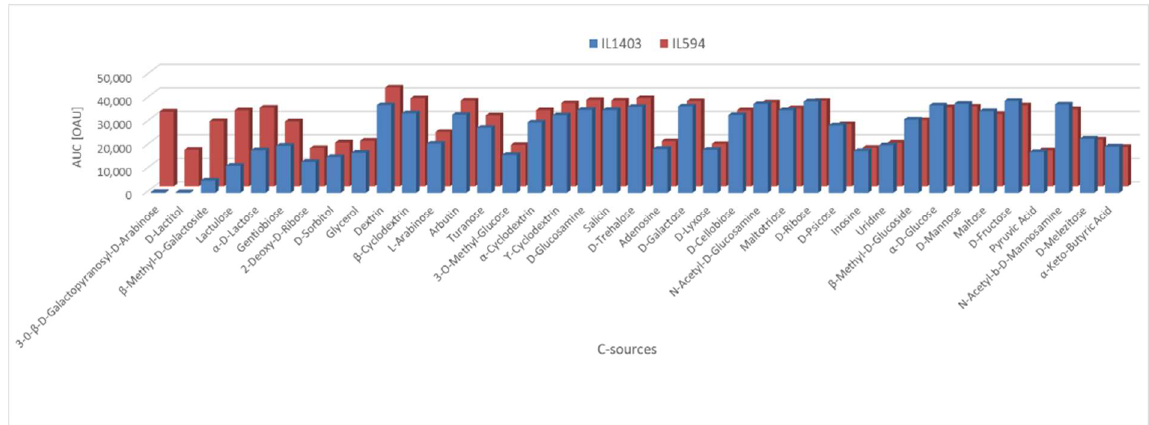
Figure 1. PM analysis for the utilization of carbon sources by L. lactis strains IL594 and IL1403. The height of the bars indicates the value of the area under the curve (AUC) of metabolic activity of the strains on a given C-source. Bars shown refer only to carbon sources for which metabolic activity of at least one strain was detected and the colorimetric reaction kinetics plot had an AUC value > 15,000 in Omnilog Arbitrary Units (OAU).